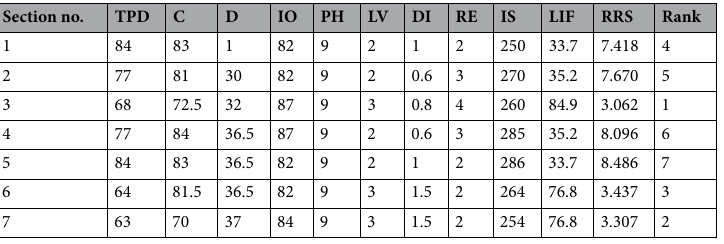
Table 6. Output RRS results of the proposed